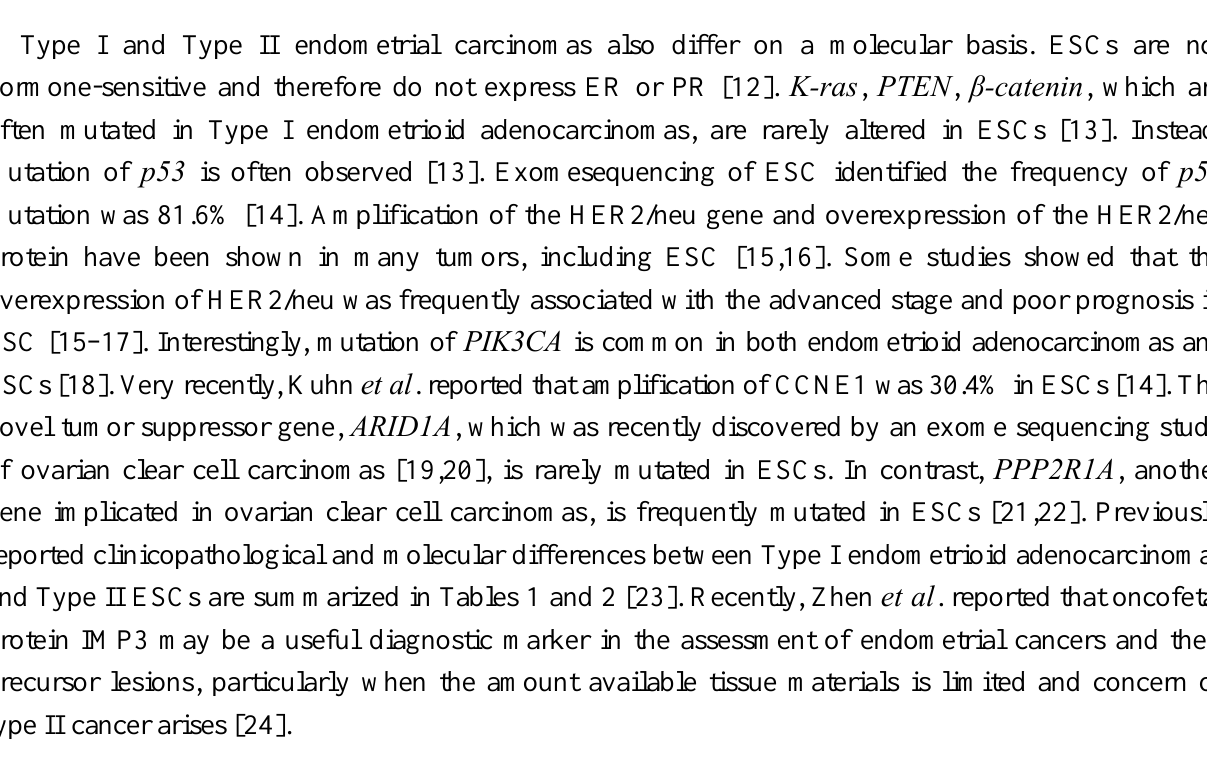
Table 1. Clinicopathological characteristics of uterine endometrioid and serous carcinomas. *